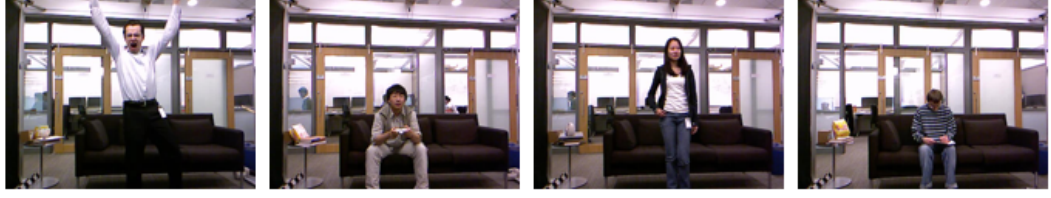
Figure 10. Samples of the MSR daily action dataset.